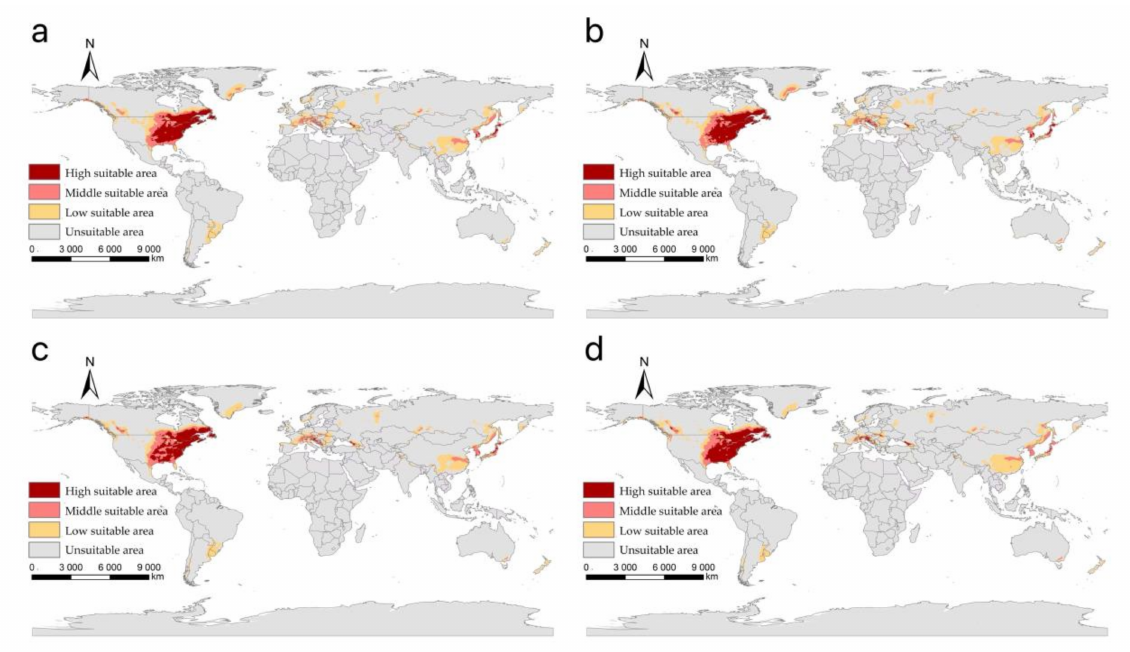
Figure 7. The suitable areas of I. scapularis around the world under shared socioeconomic pathway 5–8.5 (fossil-fuel development and forcing of 8.5 W/m 2 to 2100) during different periods of the 21st century: ( a ) 2021–2040; ( b ) 2041–2060; ( c ) 2061–2080; ( d )